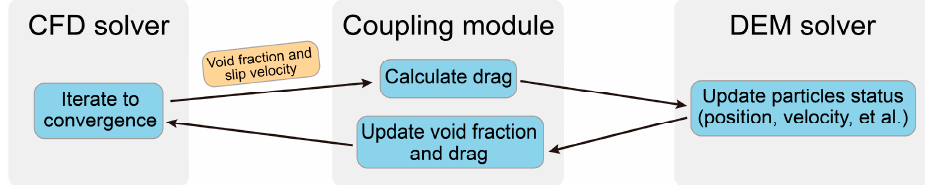
Figure 4. The momentum exchange strategy of CFDEM.